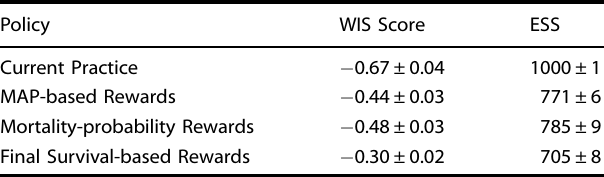
Table 1. Off-policy evaluation results of different policies across 5 bootstrap sample runs on the test